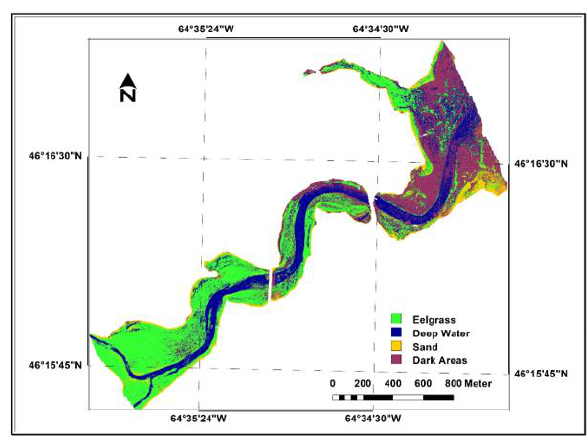
Figure 11. Classified image produced with the Maximum Likelihood Classifier (MLC) applied to the PCI Geomatica RGB mosaic of Shediac